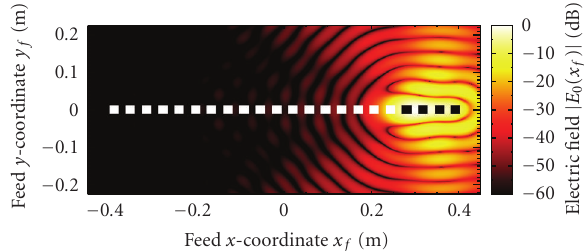
Figure 14: Normalized electric field on the feed array due to an extended pulse on the swath edge.